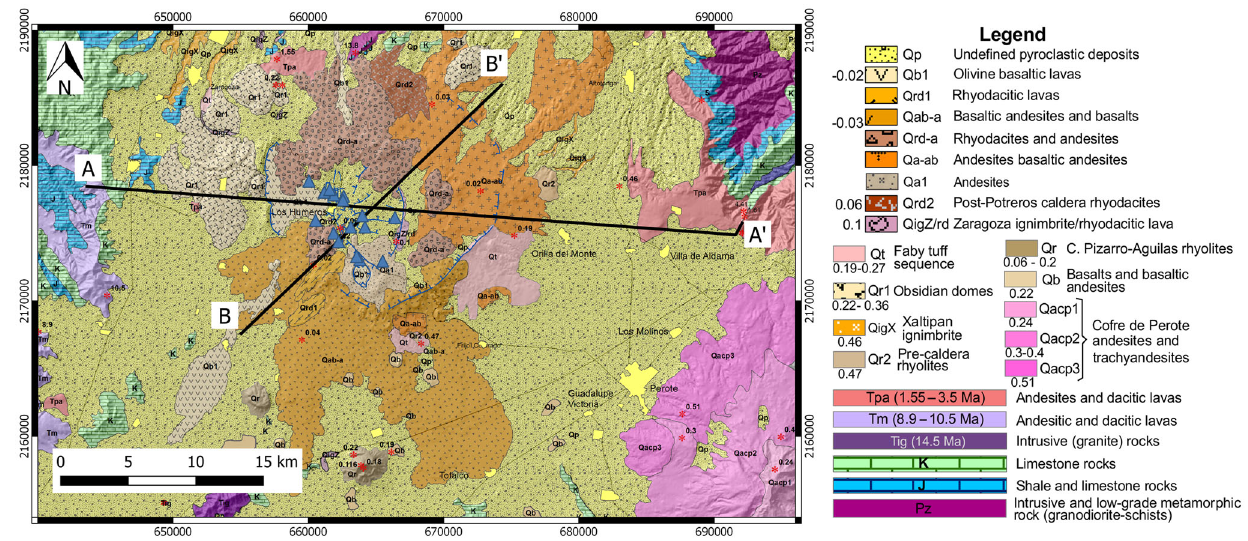
Figure 2. Geological map of Los Humeros adapted from Carrasco-Núñez et al. (2017b). Blue triangles: location of the sixteen wells used for modelling. AA’: Carrasco-Núñez et al. (2017b) cross-section trace, BB’: Norini et al. (2015) cross-section trace (see Fig. 8). Coordinate system is WGS84/UTM zone